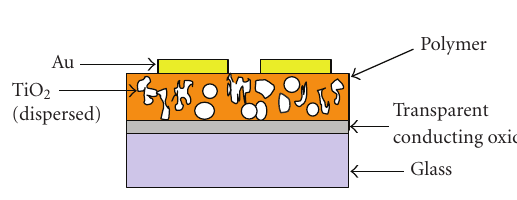
Figure 3: Absorption spectrum of PTEBS polymer.